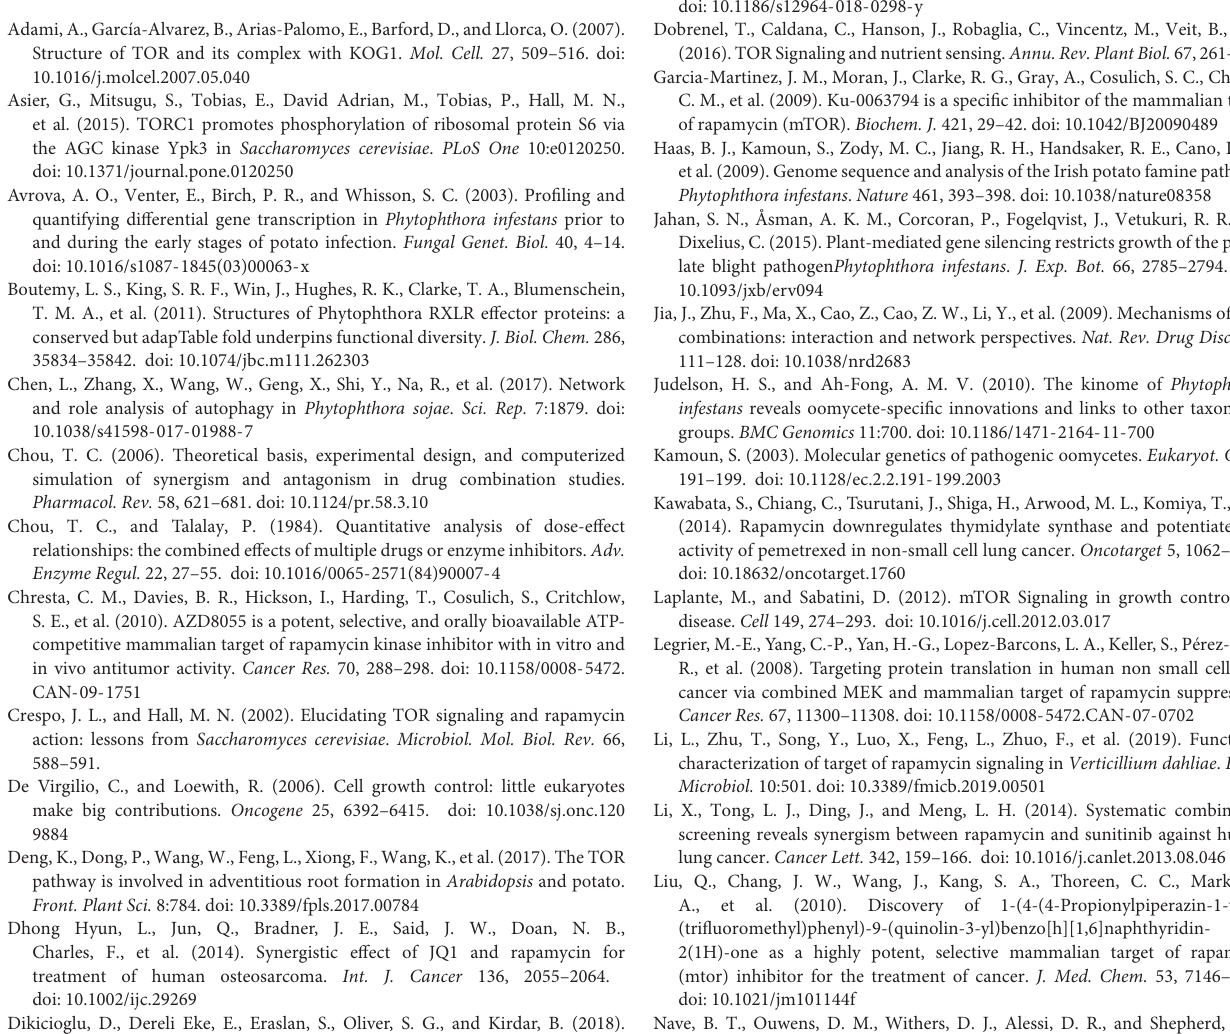
Supplementary Table 3 | IC50 of RAP, KU and RAP + KU for P. infestans T30-4 and 002. Supplementary Table 4 | IC50 of RAP, Torin1 and RAP + Torin1 for P. infestans T30-4 and 002. Supplementary Table 5 | DEGs in RAP, AZD and RAP + AZD samples, respectively. DEGs with Log2 fold change > 0 or < 0 in (A) RAP, (B) AZD and (C) RAP + AZD-treated samples. DEGs with Log2 fold change > 1 or < − 1 in (D) RAP, (E) AZD and (F) RAP + AZD-treated samples. Supplementary Table 6 | Total DEGs and synergistic DEGs. (A) Total DEGs in three samples. (B) Synergistic DEGs in RAP + AZD. Supplementary Table 7 | Top 30 GO terms in (A) RAP, (B) AZD and (C) RAP + AZD samples. (D) 22 co-existing GO terms in RAP, AZD and RAP + AZD samples. Supplementary Table 8 | Synergistic DEGs in 10 co-existing GO terms. (A) Overall synergistic DEGs in the 10 co-existing GO terms. Synergistic DEGs in the GO terms of (B) ribonucleoprotein complex, (C) ribosome, (D) cellular amide